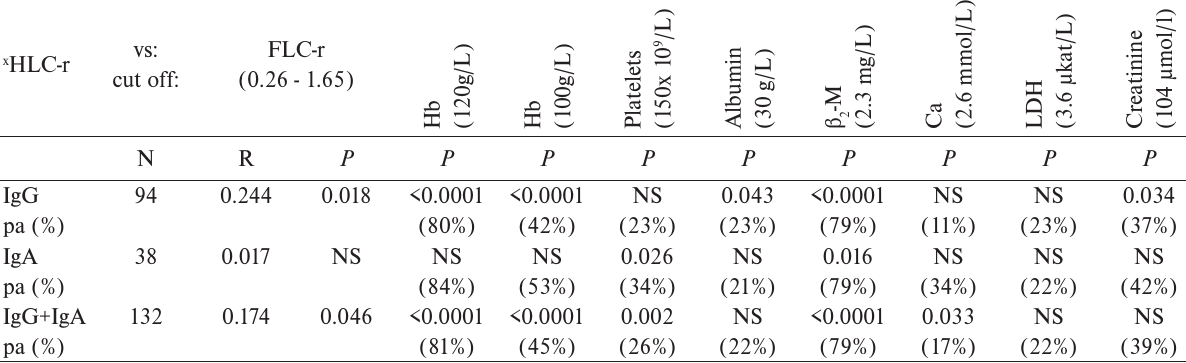
Table 3. Correlation analysis of the relationship between groups of normal vs abnormal values of selected laboratory param- eters and x HLC-r values measured with Hevylite TM in patients with IgG, IgA and IgG plus IgA type of multiple myeloma.